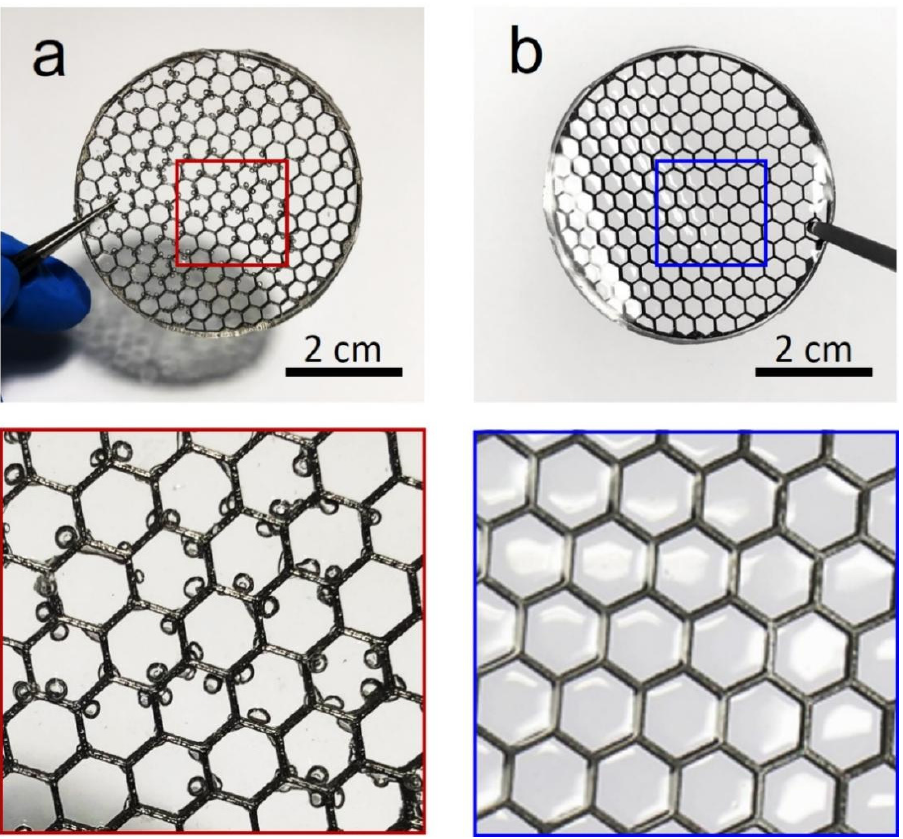
Figure 4. Photographs for Ti-PDMS cranial window samples. ( a ) Simple dipping process of the Ti frame in PDMS caused micro-bubbles. ( b ) By using a multistage shaking and degassing processes, the gas bubbles were totally removed from the